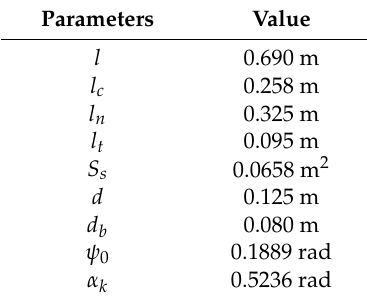
Table 3. Parameters of the missile.